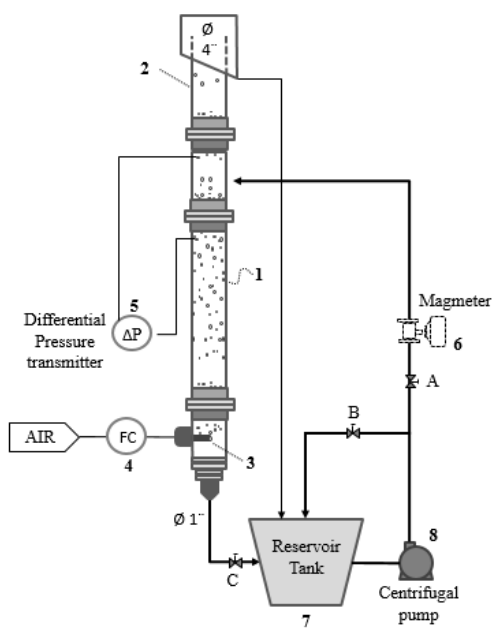
Figure 1. Schematic diagram of the apparatus. FC: flow controller.